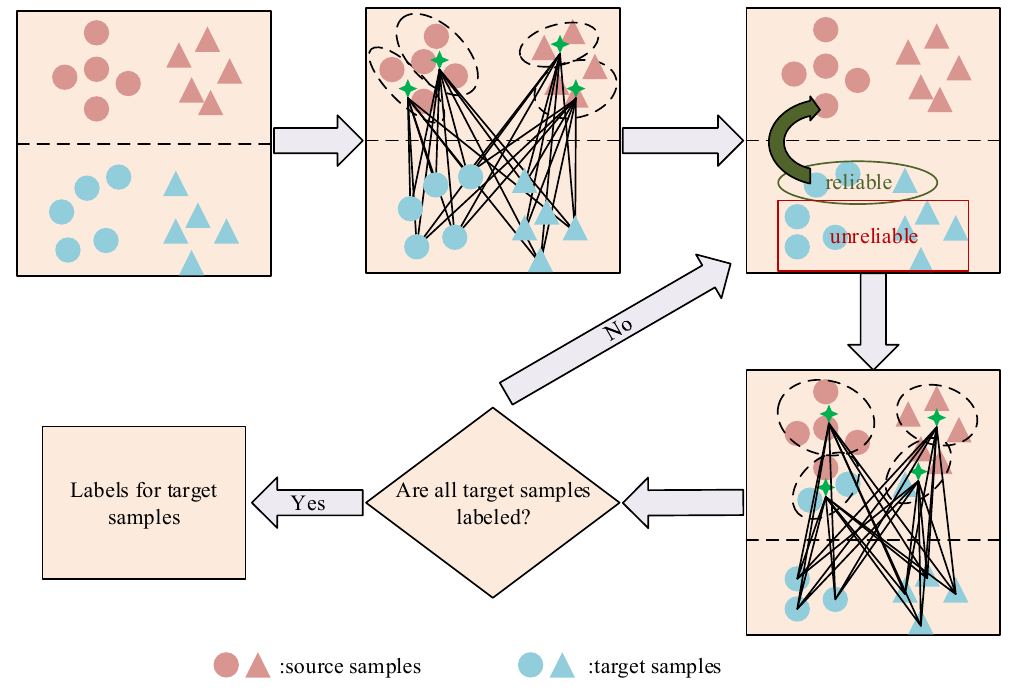
Figure 3. A graphical illustration of the total framework. First, we use the labeled source samples to construct a basic classifier, then the easy samples from the target domain are selected by considering the confidence. Adding easy samples along with their labels to the training set, a more powerful classifier can be obtained. The process continues until every target samples has been